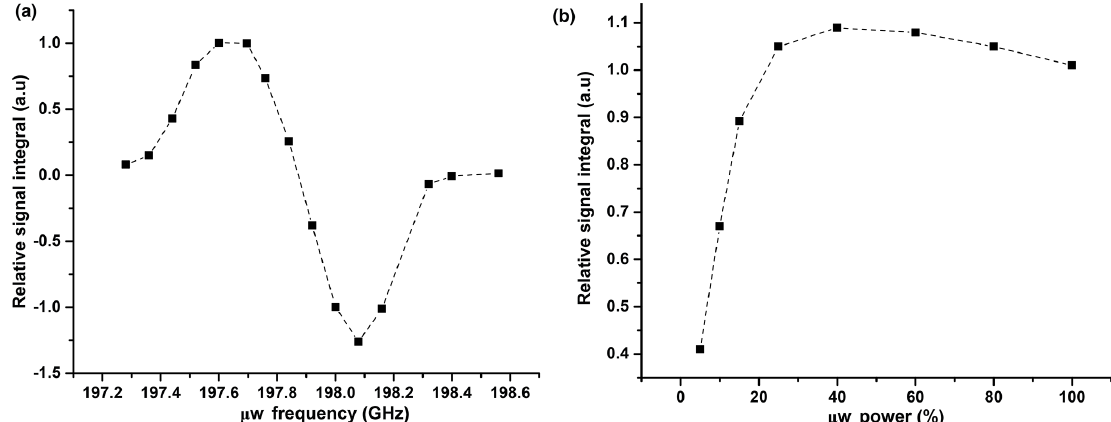
Figure A1. (a) Plot of relative 1 H DNP signal integrals vs. µw frequency at 50mM TEMPOL. Signals are normalized with respect to the signal at 197.69GHz. (b) Plot of relative 1 H DNP signal integrals vs. µw power (%). Signals are normalized with respect to the signal at 198.08GHz with a triangular frequency modulation with a bandwidth ( (cid:49)f µw ) of ± 5MHz and frequency of